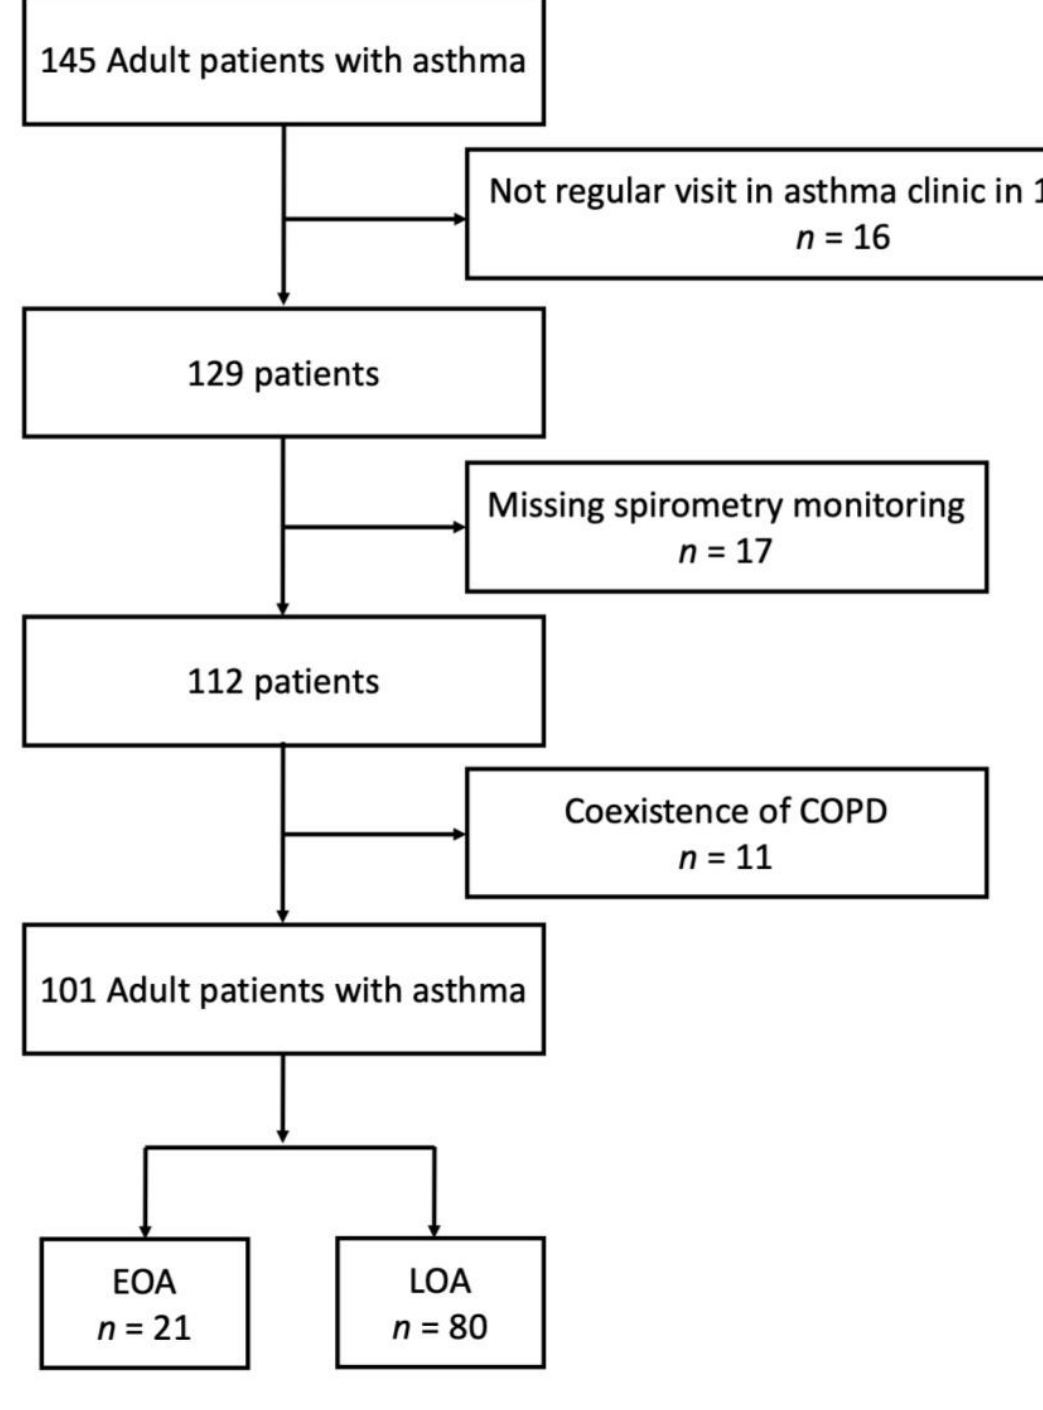
Figure 1. Study profile: The number of patients enrolled and analyzed in the study. Table 1. Characteristics of patients with early-onset and late-onset asthma.